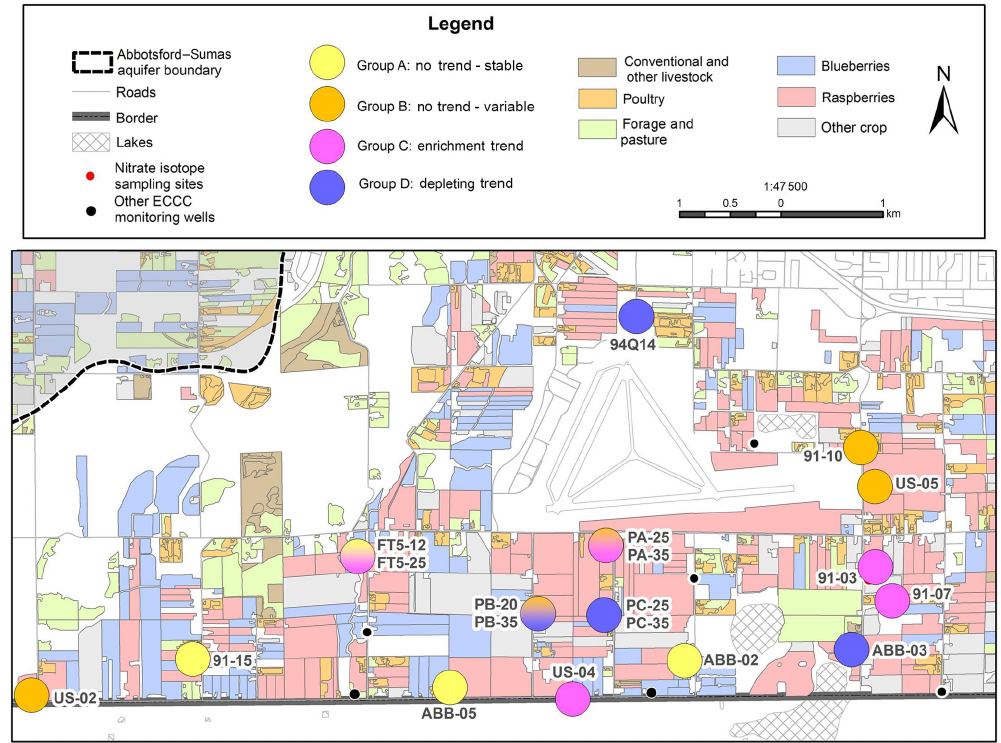
Figure 6. Spatial distribution of δ 15 N trend groupings, along with agricultural land